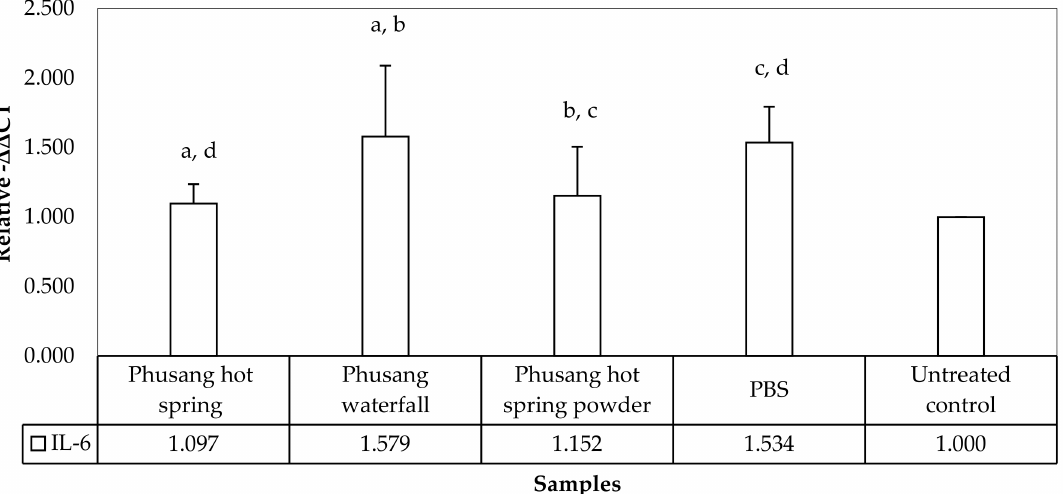
Figure 6. IL-6 expression levels in cultured PBMCs at 24 h, as determined using a semi qRT–PCR analysis (a, b, c, d = statistically significant differences).